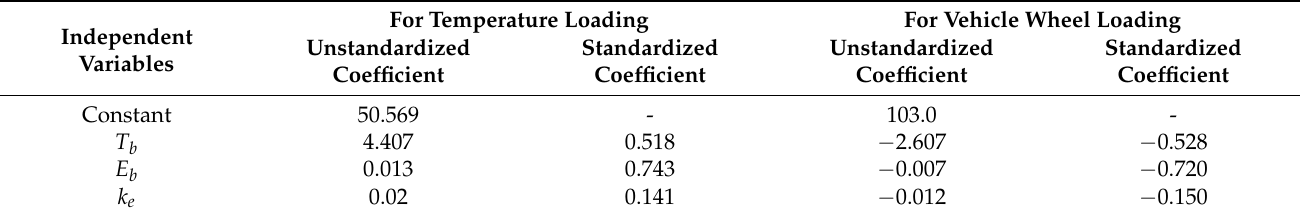
Table 9. Regression coefficients for critical stress under temperature and vehicle wheel loadings. T b , thickness of the stabilized base layer; E b , elastic modulus of the base material; k e , effective k -value. Independent